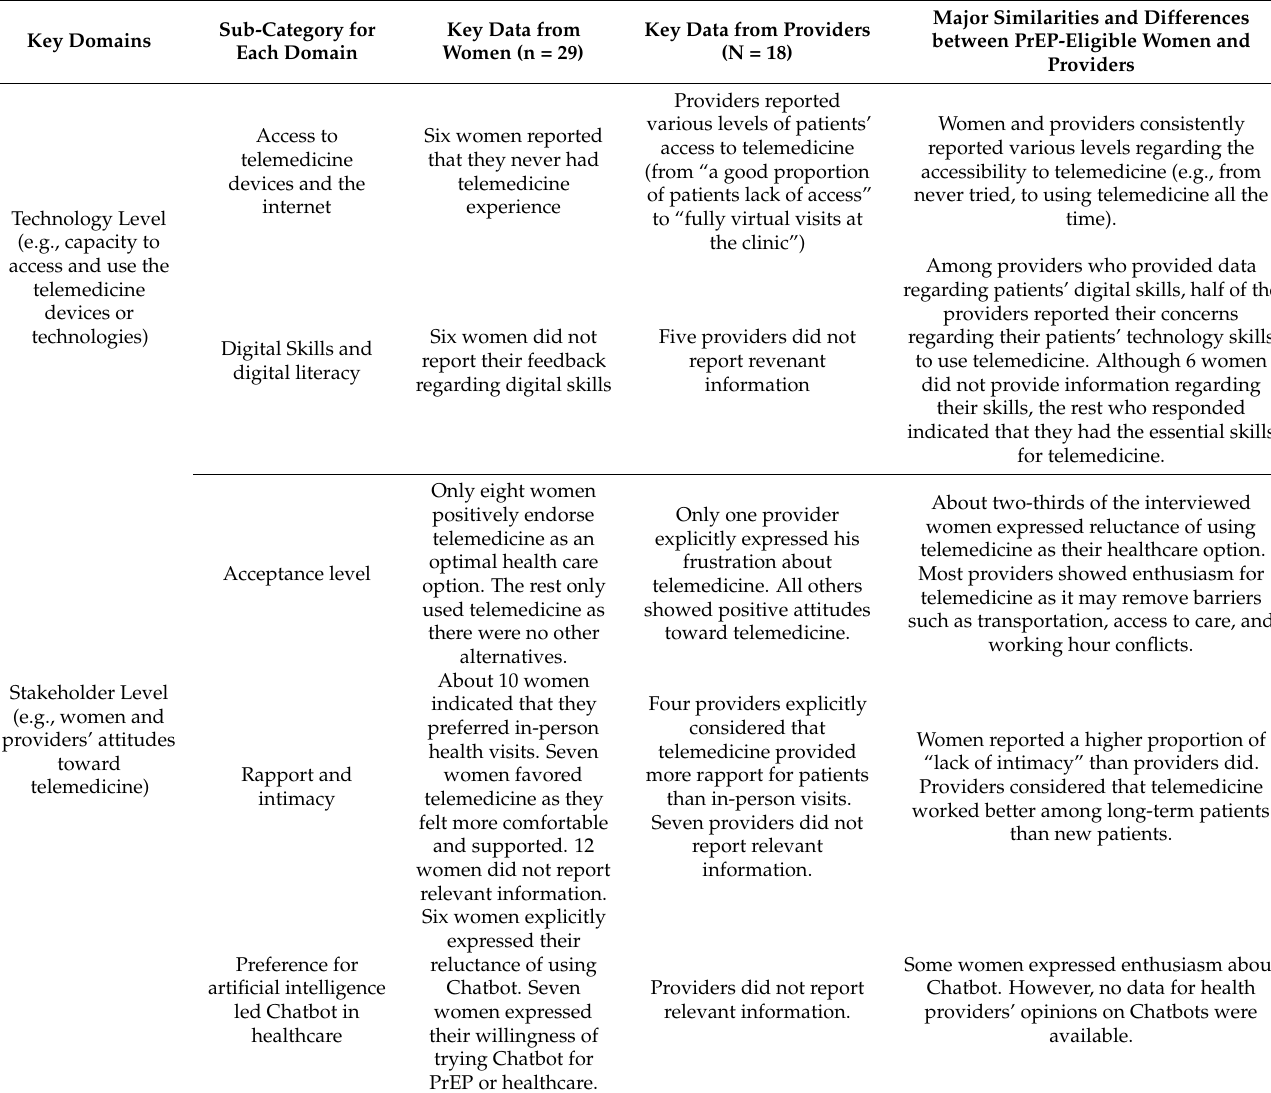
Table 2. Summary of key findings from PrEP-eligible women and their primary health